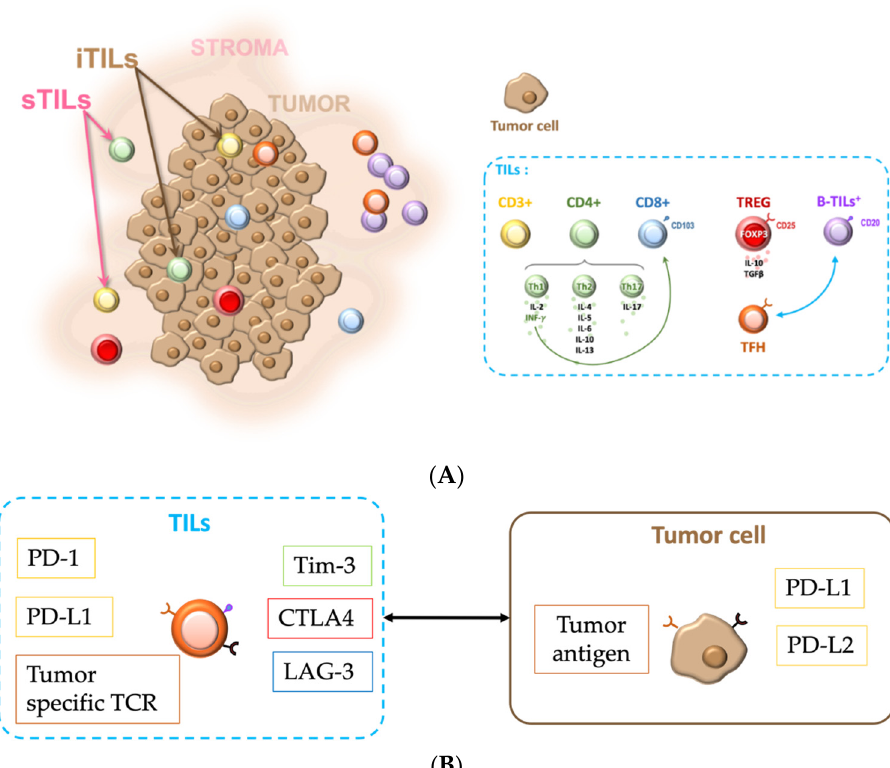
Figure 2. Immunologic network in EOC : ( A ) simplified TIL view and location ; ( B ) Main immune checkpoints studied in EOC . Simplified diagram of the main TILs described in the articles studied in this review. T cells infiltrating the stroma or tumor epithelium are identified via CD3, and/or CD4 and CD8. The subtypes of T cells, including TH1, TH2, TH17, TFH, and TREG, are illustrated. The main immune checkpoints described in this review are represented. iTILs: intra-tumoral, sTILs: stromal, B-TILs: B tumor-infiltrating lymphocytes, TCR: T cell receptor, PD-1: programmed-death 1, PD-L1: PD-1 ligand 1, PD-L2: PD-1 ligand 2, CTLA4: cytotoxic T-lymphocyte-associated protein activating gene